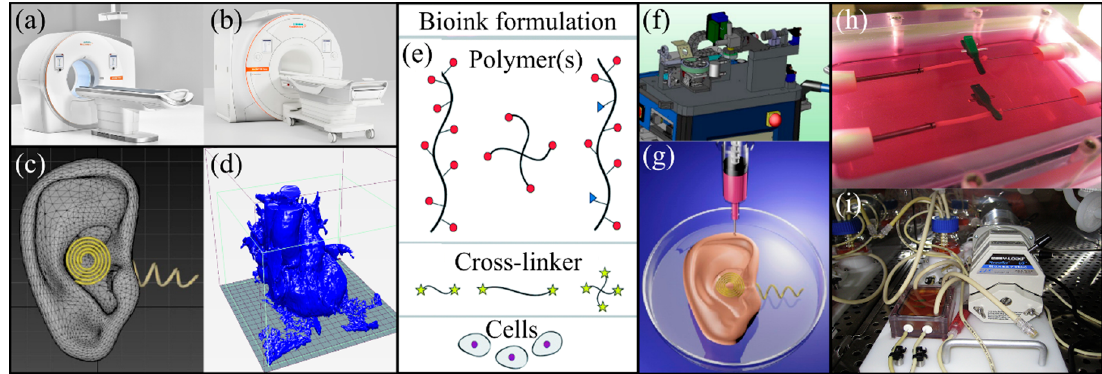
Figure 1. A typical process for bioprinting 3D tissues. Imaging of the tissue or organ using 59 (a)CT scanner (shown here is a Siemens SOMATOM Force © Siemens Healthcare GmbH, 60 scanner (shown here is a Siemens SOMATOM Force © Siemens Healthcare GmbH, 2018), or ( b ) MRI 2018), or (b) MRI machine (shown here is a Siemens MAGNETOM Sola © Siemens 61 machine (shown here is a Siemens MAGNETOM Sola © Siemens Healthcare GmbH, 2018) Healthcare GmbH, 2018) and (c-d) reconstruction of 3D models from the imaging (shown 62 here are models of a near and a heart). (e) The composition of bioink depends on the 63